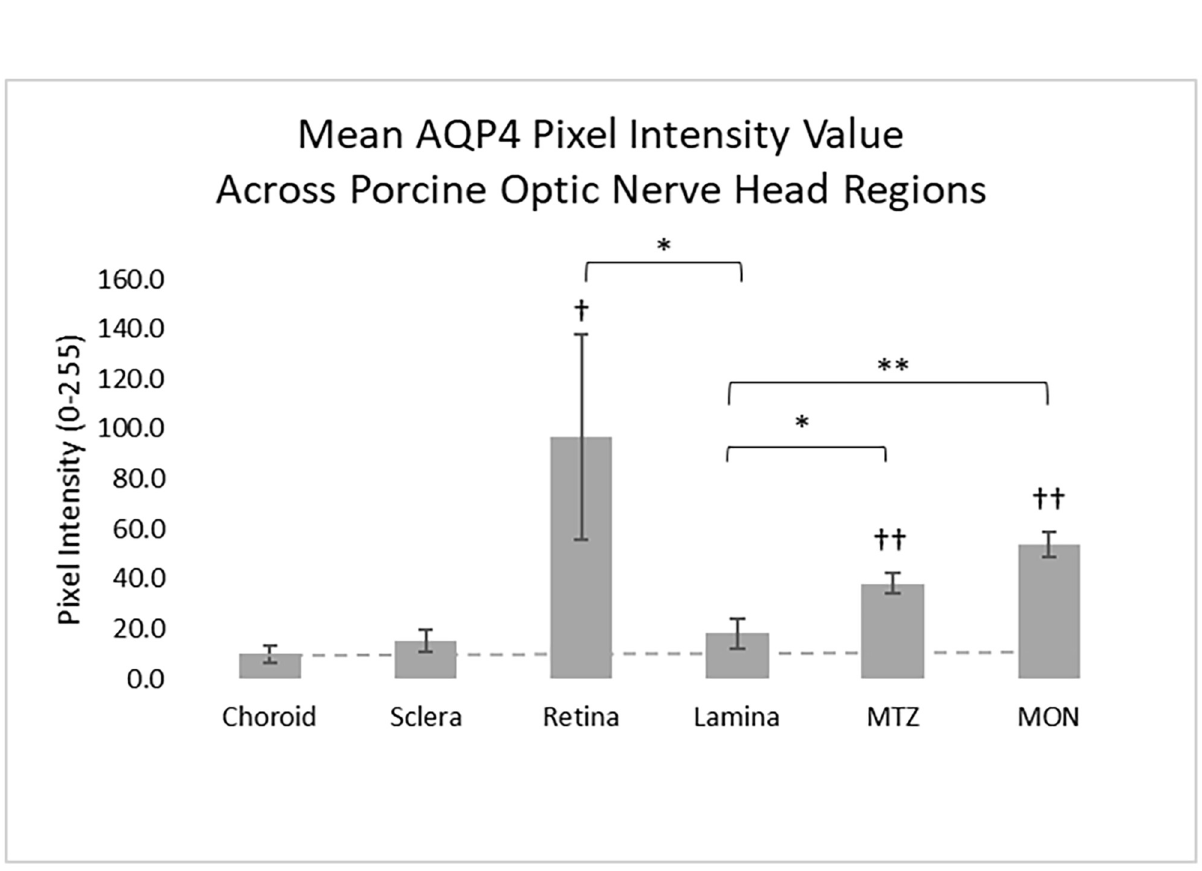
Fig 6. Semi-quantification of aquaporin-4 labeling in 6 regions of porcine ONH region. Values in choroid, sclera, and lamina are minimal, not significantly different from each other, while each was significantly lower than retina, myelin transition zone (MTZ), and myelinated optic nerve (MON). Mean ± standard errors. Dotted line identifies the AQP4 background level in choroid. †p < 0.05, ††p < 0.01 for difference from control choroid. � p < 0.05, �� p < 0.01 for difference from lamina.